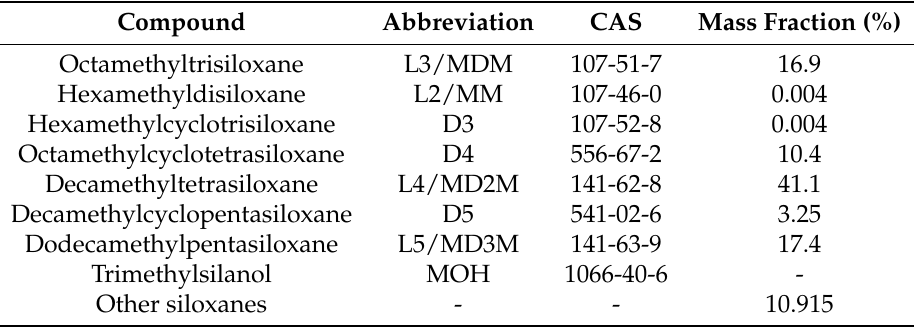
Table 11. HS-GC-MS analysis results of Experiment B, residue.